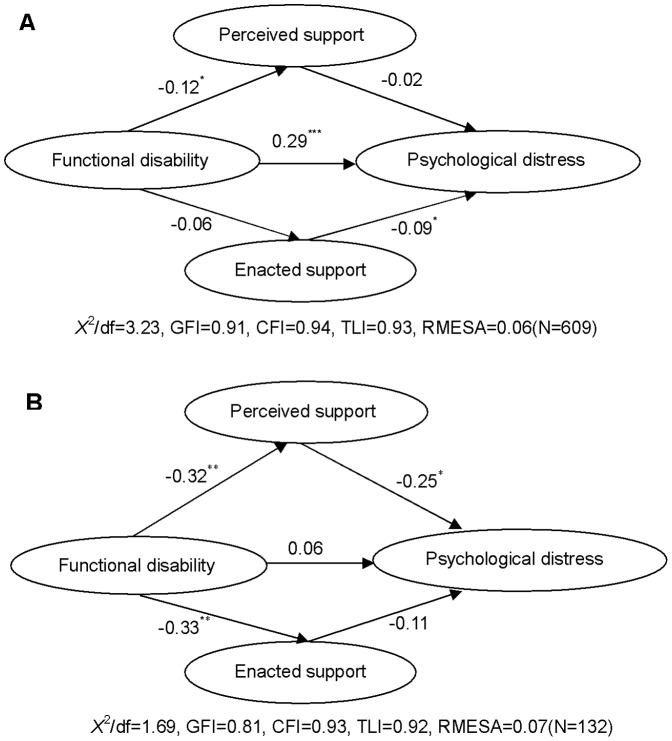
Results of SEM analysis among the people <75 years old (A) and the people ≥75 years old (B).All the coefficients in the figures are standardized. Observed indicators for the latent factors are not shown. *p<0.05, **p<0.01,*** p<0.001.